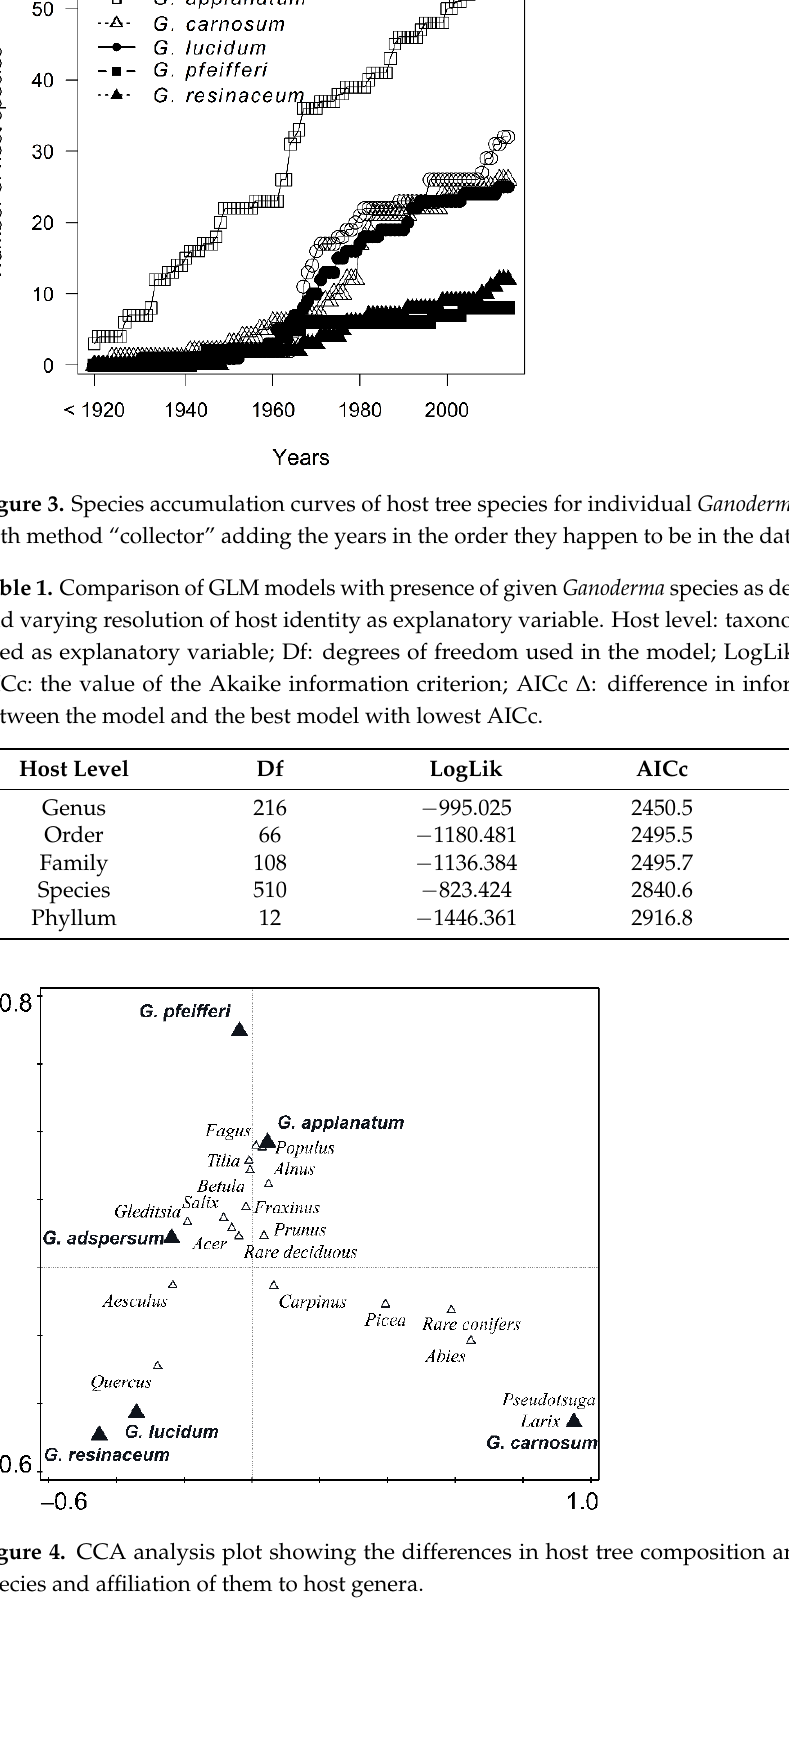
Figure 5. Genera accumulation curves showing the level of host specificity of individual Ganoderma species. The axes shortened for clarity. Table 2. Number of records for individual Ganoderma species associated with different host genera (ranked by appear- ance). Host Genera